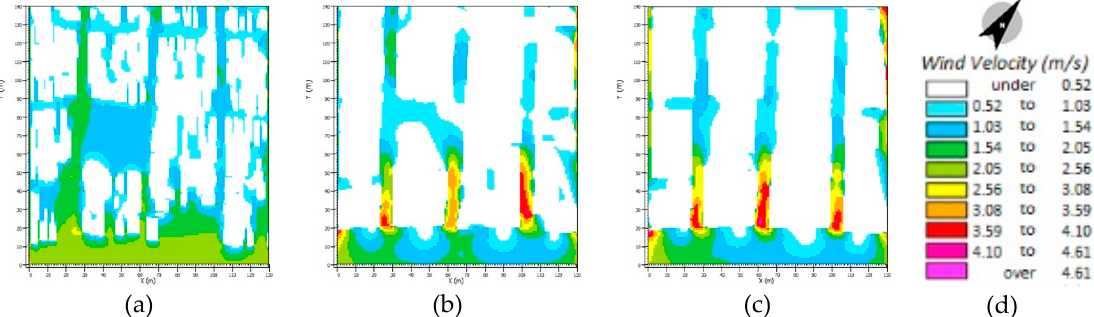
Figure 7. Ventilation (m/s) results for January 2018 (average), 8 p.m.: ( a ) Sprawl Morphology (urban form data: 1930); ( b ) Medium Morphology (urban form data: 1950); ( c ) Density Morphology (urban form data: 2018); and ( d ) Color scale.